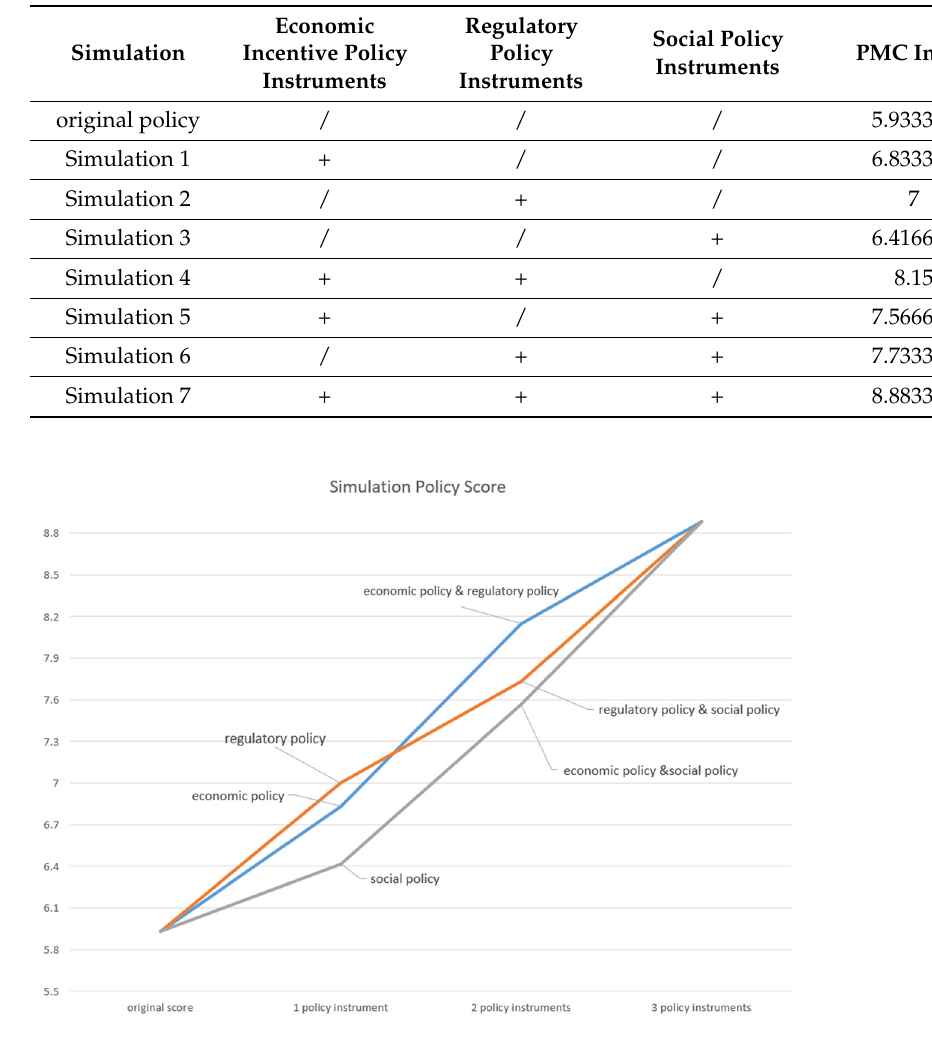
Figure 5. The impacts of different types of policy instruments on the P6 PMC index.